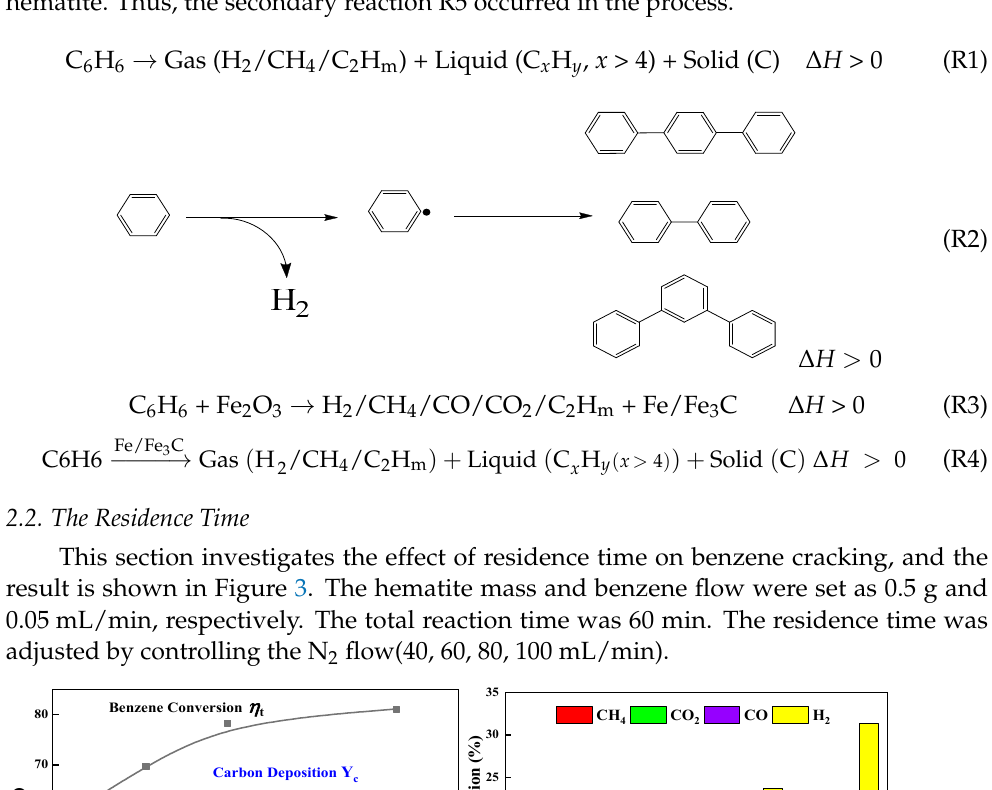
Table 5. XRF analysis of hematite.